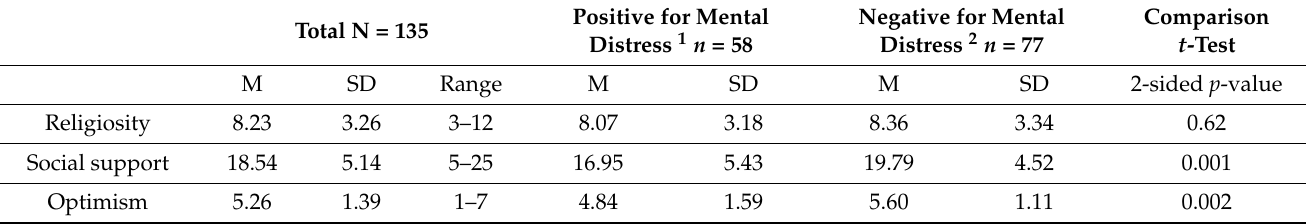
Table 2. Optimism, social support and religiosity: Comparison between mentally disordered and non-mentally disordered study participants.